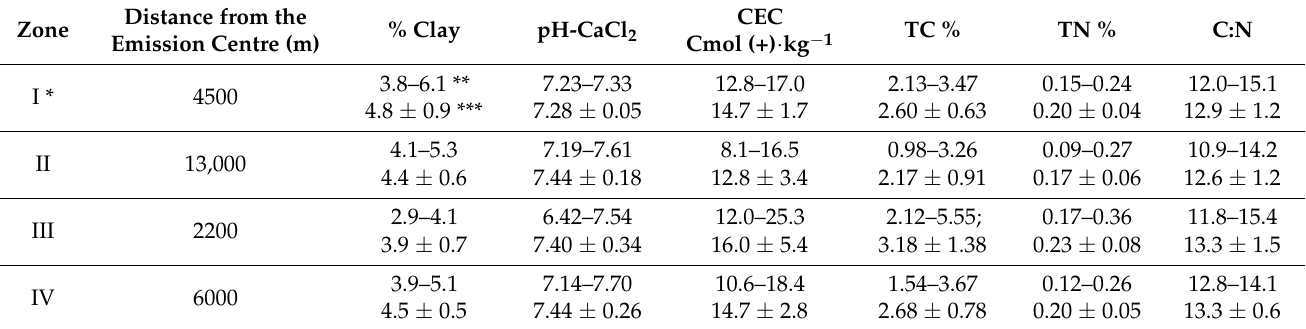
Table 1. General characteristics of soils representing individual